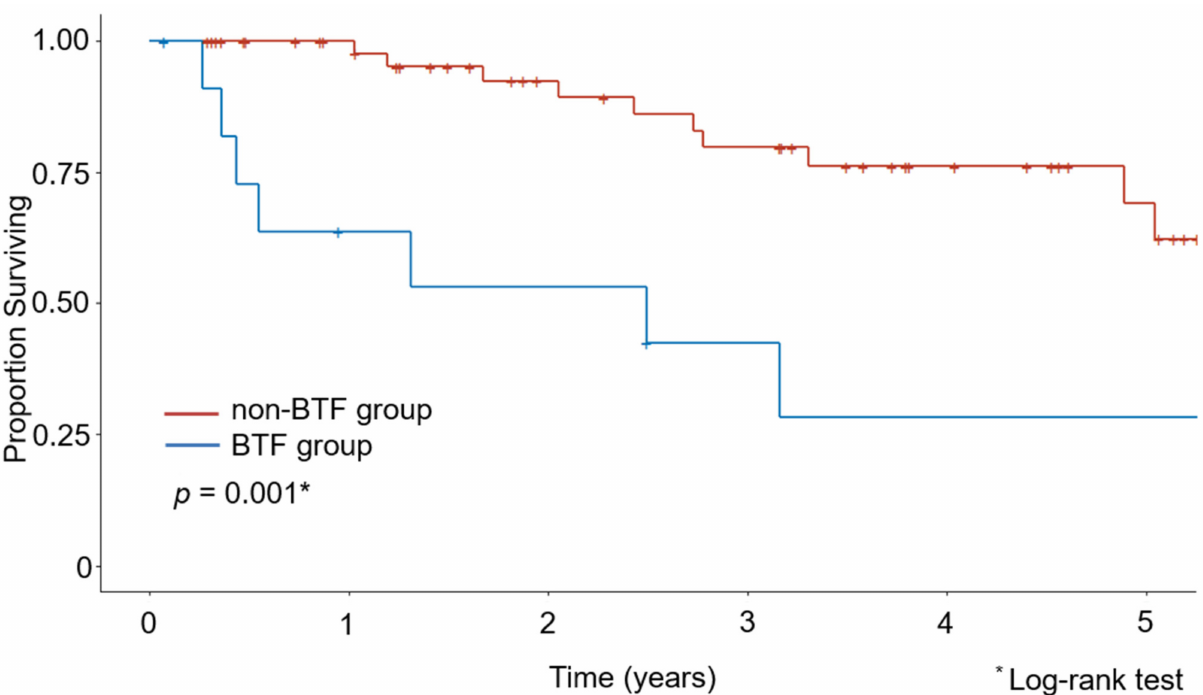
Figure 1. Kaplan–Meier estimates of overall survival in the intraoperative blood transfusion (BTF) and non-BTF groups.